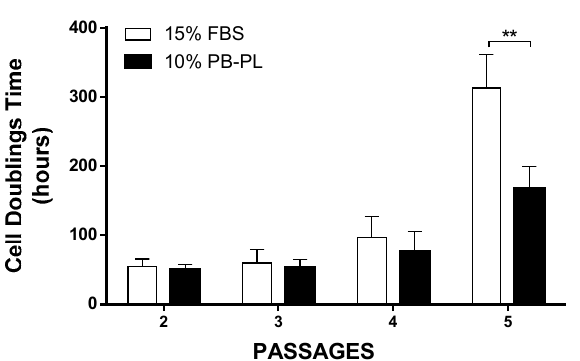
Figure 3. Cell doubling time of WJ-MSCs treated with FBS and PB-PL growth medium. At passage 5, the WJ-MSCs treated with PB-PL growth medium showed statistical significant reduction in CDT, compared to FBS expanded WJ-MSCs. The significance of the difference between the FBS and PB-PL